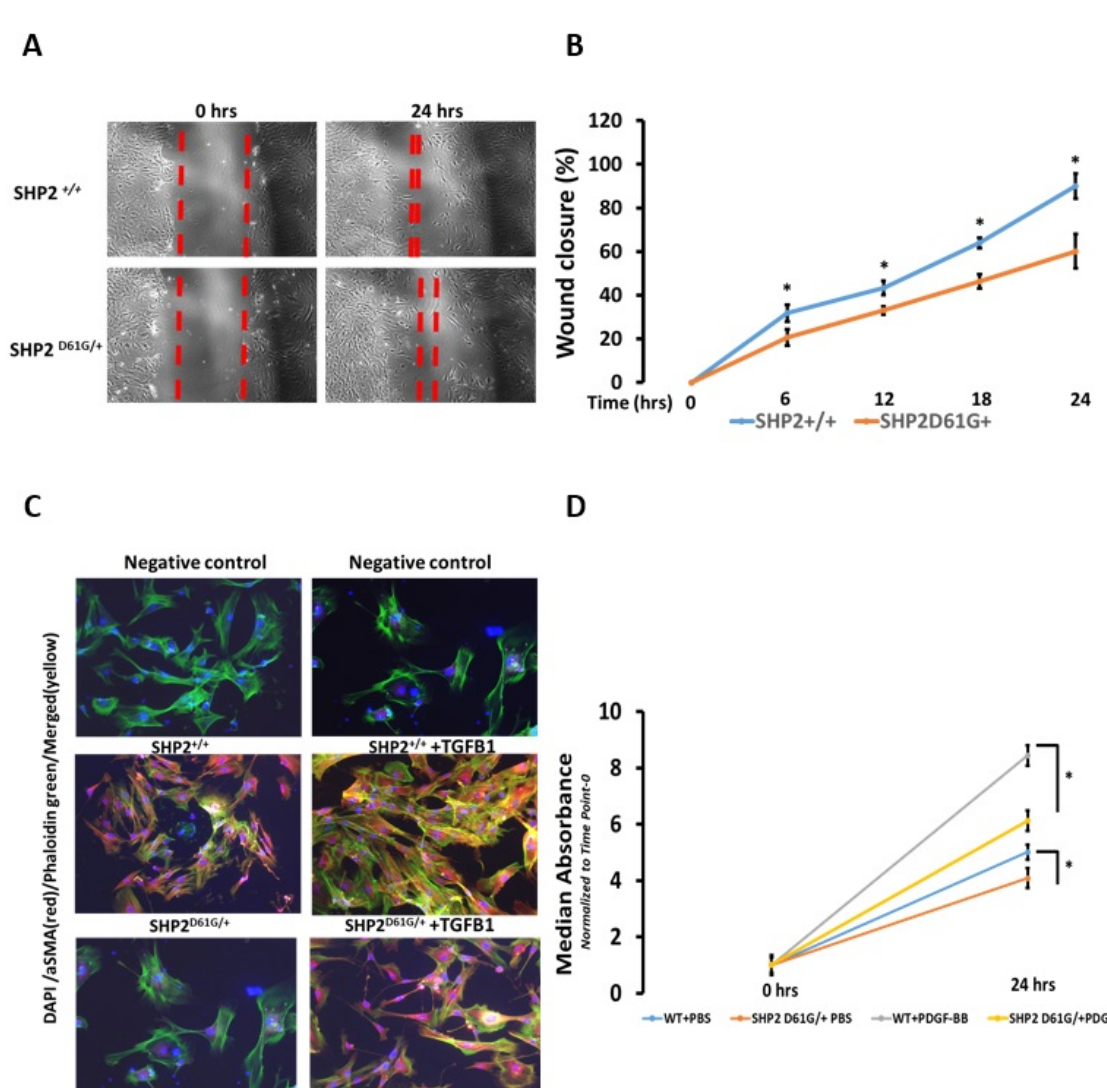
Figure 1. SHP2 D61G/+ constitutively active mutant negatively regulates fibroblast migration, myofibroblast differentiation, and proliferation. ( A , B ) SHP2 D61G/+ constitutively active mutant lung fibroblasts exhibited significantly reduced cell migration at all time points (T0-T24, 2-fold) compared to wild-type ones (SHP2 +/+ ). One way ANOVA, * p < 0.05. ( C ) Double immunofluorescence analysis in representative primary MLF samples showing decrease in TGFB1-induced a-SMA (red) and stress fibers as indicated by phalloidin green (merged-yellow) in SHP2 D61G/+ constitutively active mutant lung fibroblasts compared to wild-type ones (SHP2 +/+ ). ( D ) PDGF-BB stimulation induced a significant increase (1.4-fold) in proliferation rates of SHP2 +/+ MLFs compared to the SHP2 D61G/+ . Each bar represents mean expression of 6 samples (biological replicates). Data (absorbance) represent mean + SD. One-way ANOVA, * p < 0.05. Details for this figure are presented in Supplemental Data S1.